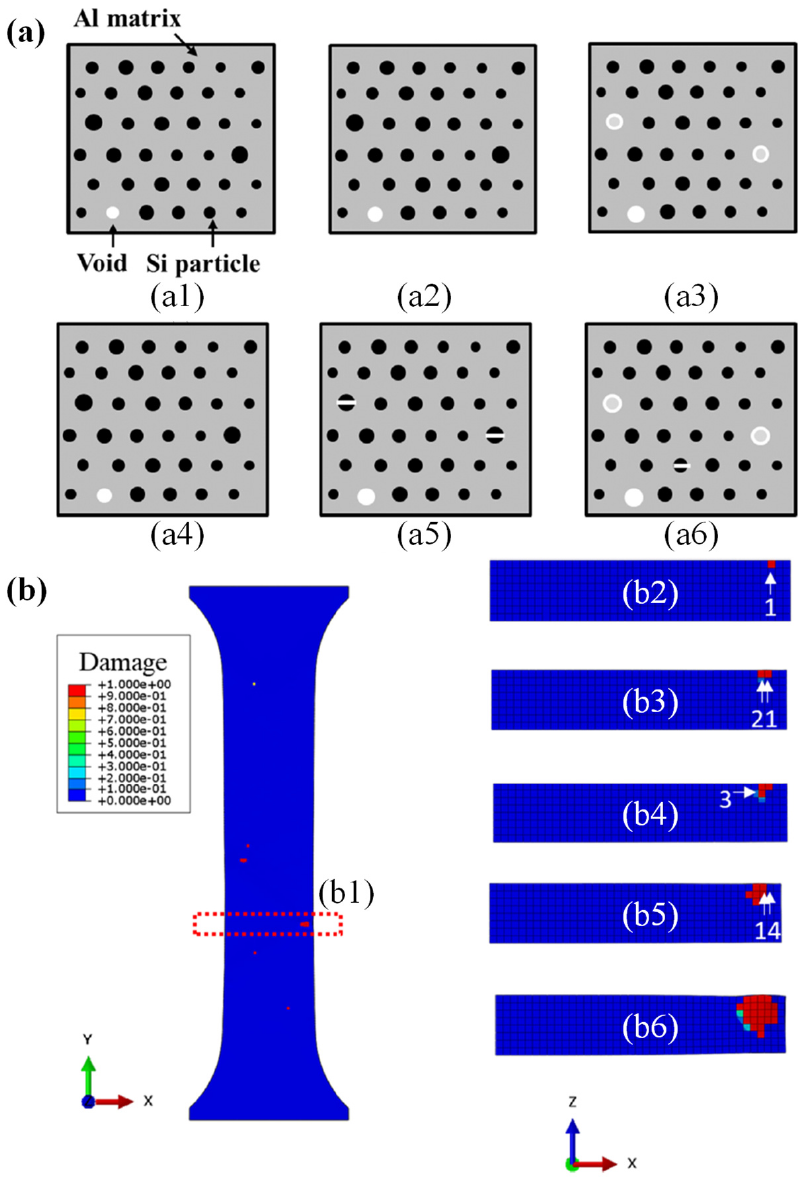
Figure 4. A schematic description of coupling numerical simulation with fracture model to predict internal cracks. ( a ) The damage evolution at the material point: (a1), (a2) and (a3) are the start of time step increment; (a4)–(a6) are the post-time steps of (a1), (a2), and (a3), respectively. ( b ) The damage value contour of simple tension simulation: (b1) shows the whole model in the X–Y plane, and (b2)–(b6) shows damage propagation in the Z–X plane through time at the red marked region in (b1). Reproduced with permission [24]. Copyright 2022, Elsevier.